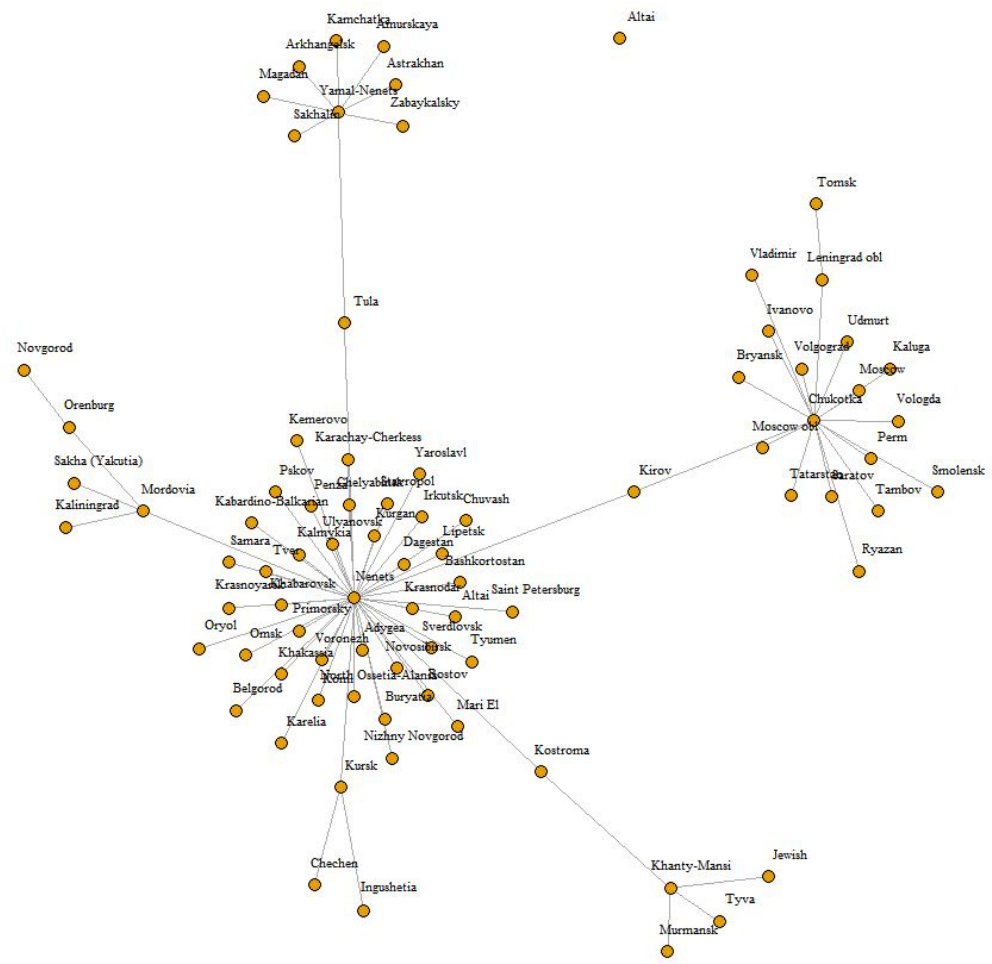
Figure 4. Minimum spanning tree for